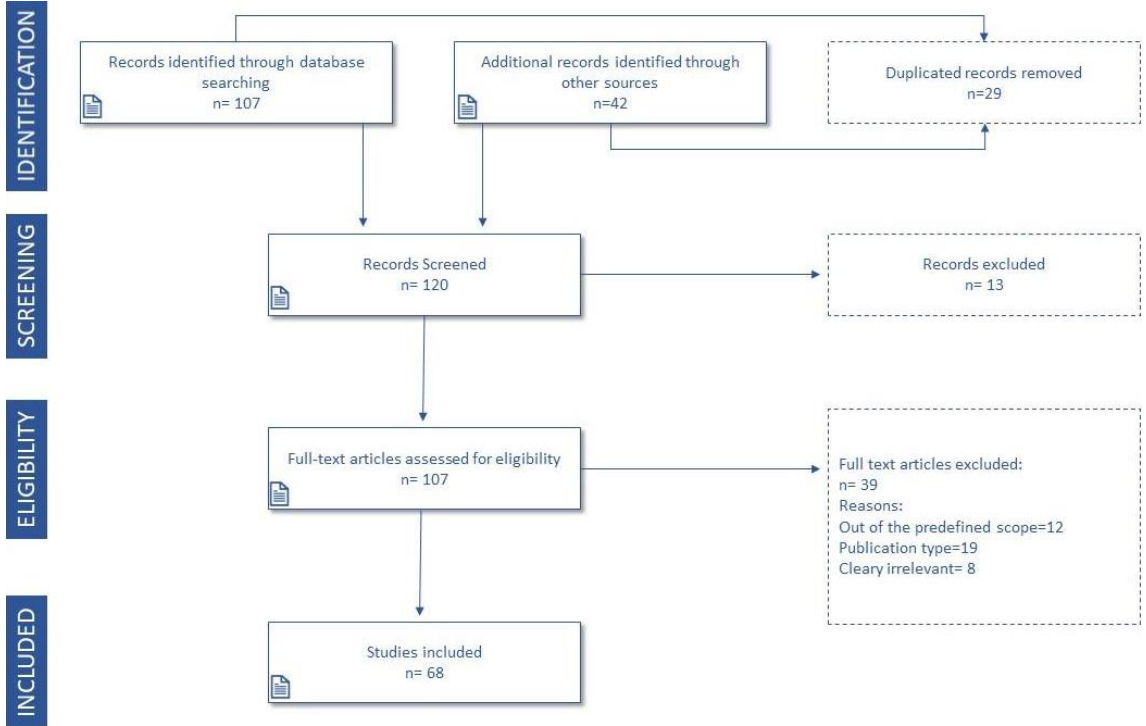
Figure 1. PRISMA Diagram information flow used for literature review.